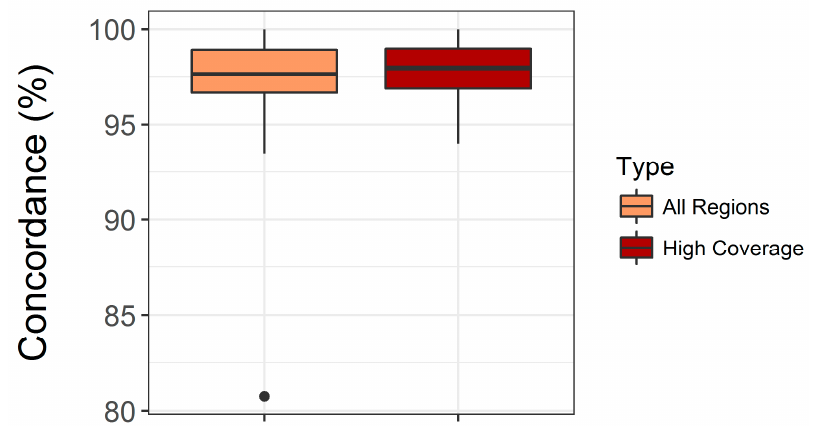
Figure 1. Concordance of variant calls, dried blood spot (DBS) versus venous blood. Variant calls were compared in both the whole panel (“All Regions”) or in regions with coverage over 50× only (“High Coverage”). n = 33.